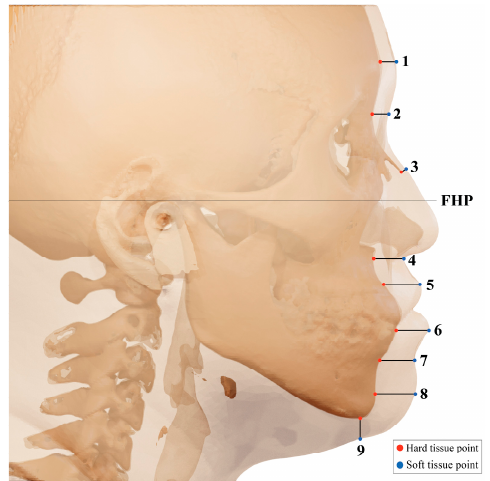
Figure 1. Division and profile of the 3 skeletal classes. FHP was measured at 9 landmarks in the middle line of the anatomical landmark: 1. glabella (G); 2. nasion (N); 3. rhinion (Rhi); 4. subnasale (Sn); 5. labrale superius (Ls); 6. labrale inferius (Li); 7. labiomentale (Lbm); 8. pogonion (Pog); and 9. gnathion (Gn). Landmarks were perpendicular to the FHP or bone surface (Figure 2).